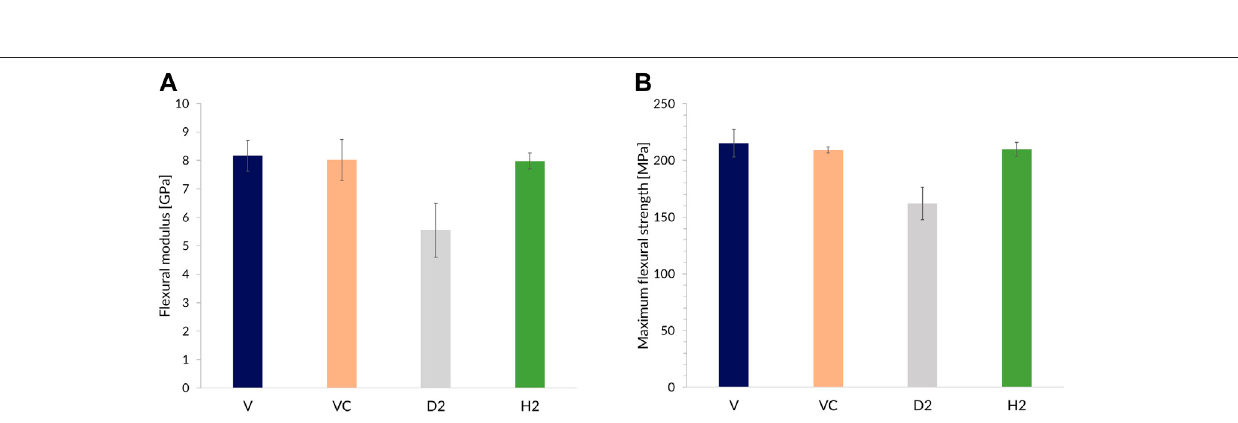
FIGURE 7 | (A) The fl exural modulus and (B) the fl exural strength for V, VC, D2, and H2 [(+45/ − 45)] 18 specimens.